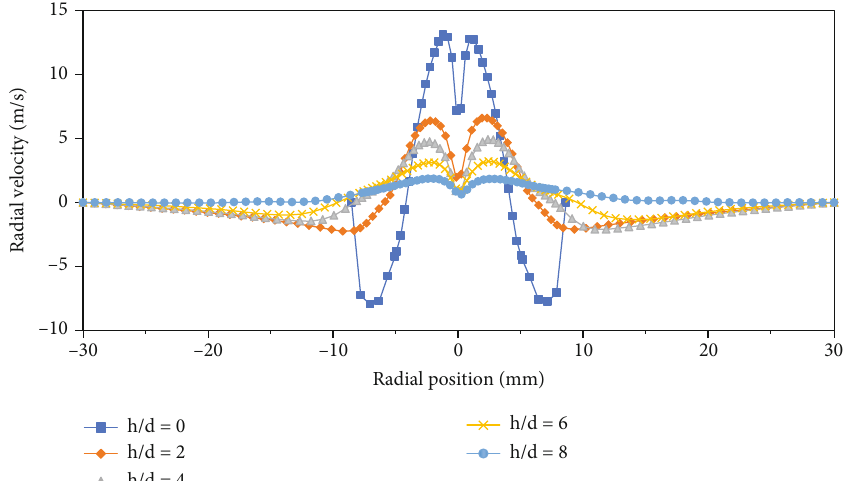
Figure 12: Development of radial velocity of